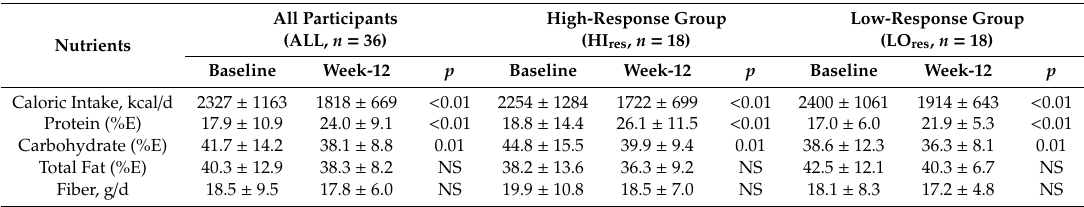
Table 1. Average nutrient